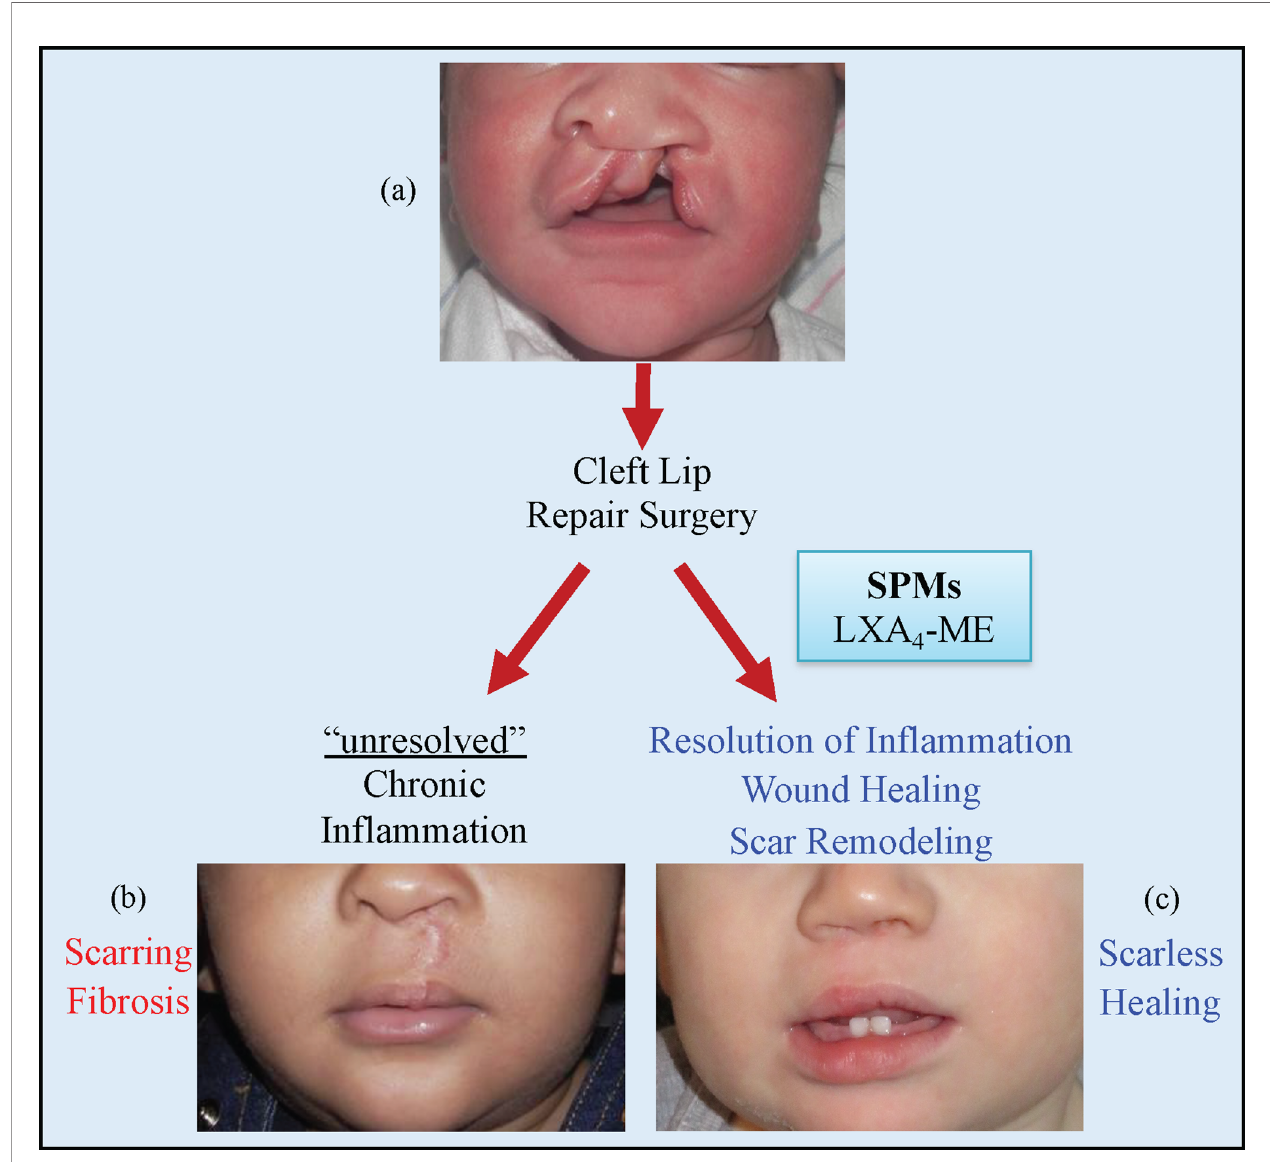
FIGURE 7 | Cleft lip (A) is the most common congenital malformation of the head and the third most common birth defect. Surgical repair is the only treatment for cleft lip and usually happens during the early months of life. Failure of resolution of acute in fl ammation after cleft lip repair surgery will lead to chronic in fl ammation with scarring and fi brosis (B) . Modulation of in fl ammatory resolution pathways in acute and chronic wounds via the topical application of LXA 4 -ME and other Specialized Pro-resolving Mediators (SPMs) can optimize wound healing (C) and is a promising therapeutic avenue to reduce scarring after cleft lip repair surgeries and other surgical